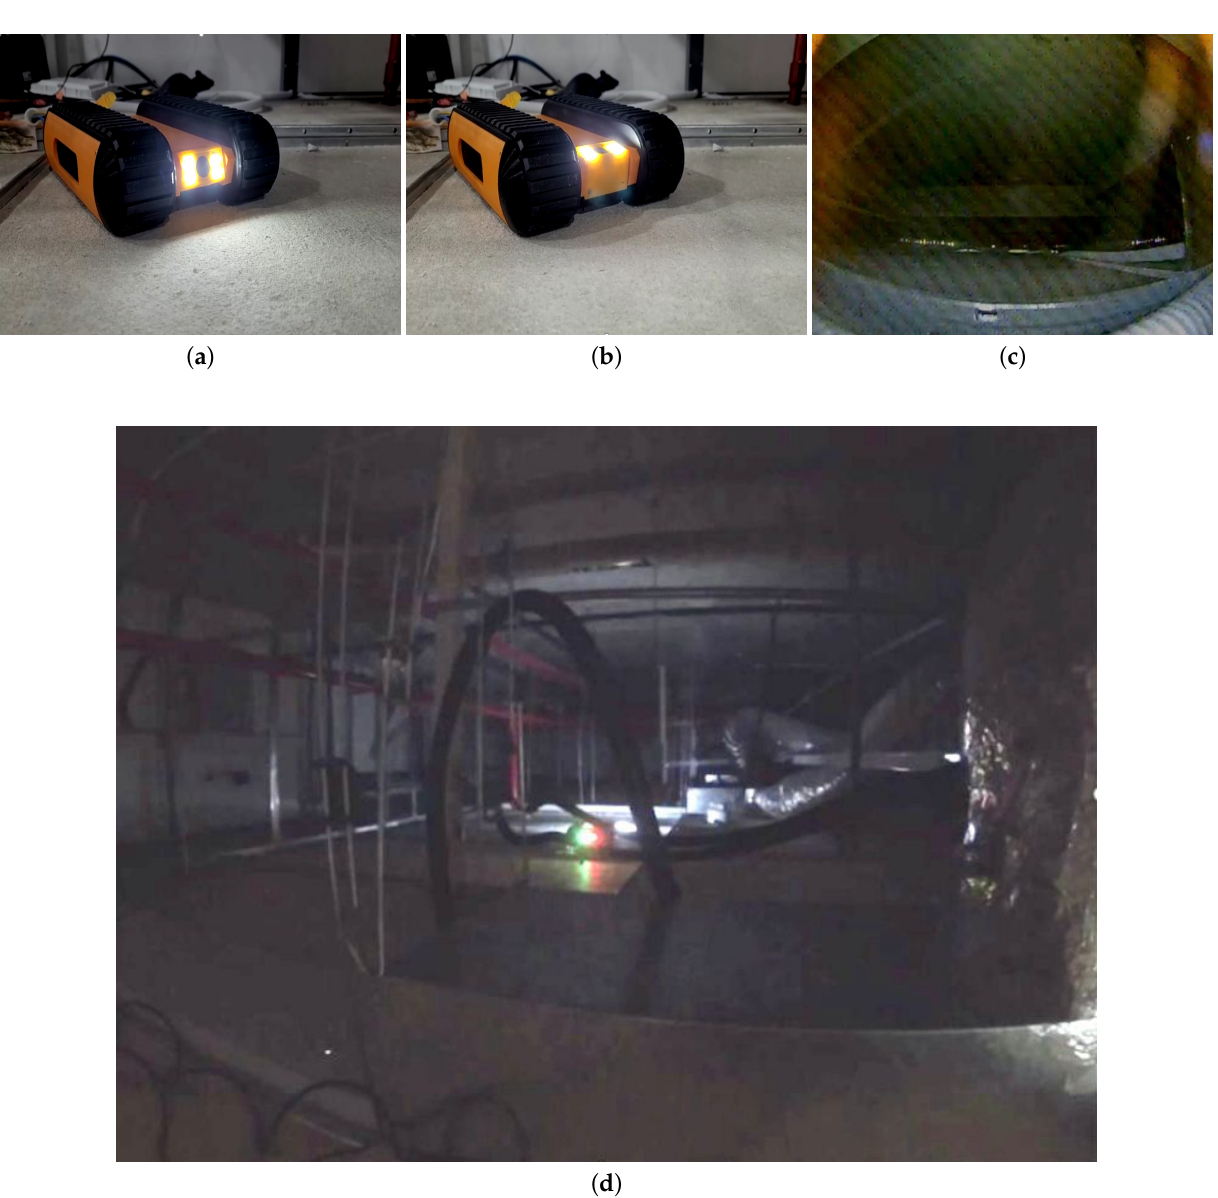
Figure 10. Falcon’s performance on the false ceiling prototype at Oceanica Robotics. ( a ) Falcon in Prototype of False Ceiling (Camera at 0 degree); ( b ) Falcon in Prototype of False Ceiling (Camera at 90 degree); ( c ) Image collected by Falcon; ( d ) Falcon in Prototype of False Ceiling (Zoomed out).